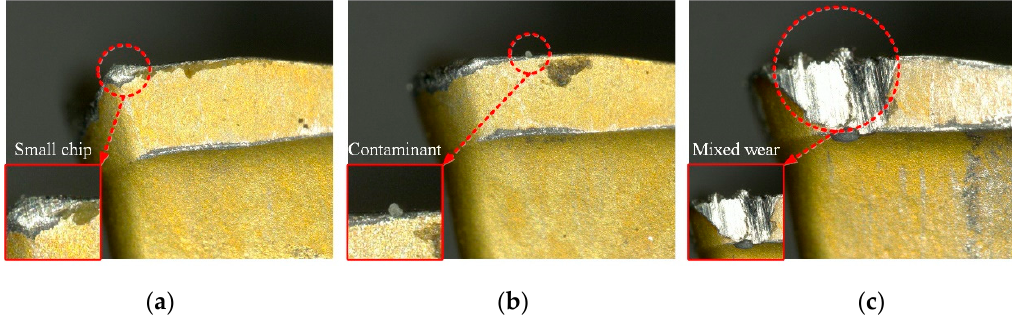
Figure 7. Images of the detection error cases. ( a ) adhesive wear, ( b ) flank wear, ( c ) multiple wear coexist.